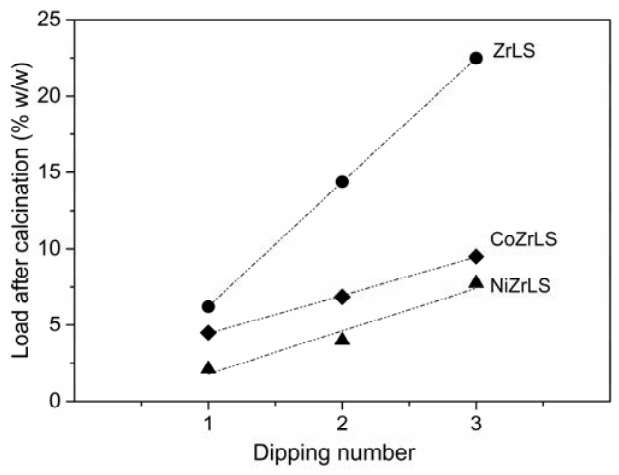
Figure 6. Coating load as a function of the dipping numbers.